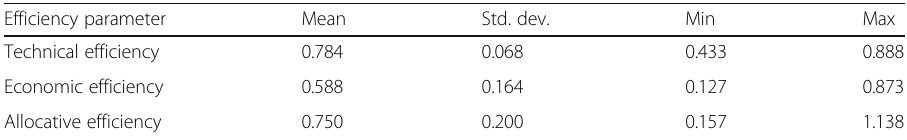
Table 4 Mean efficiencies of rice production in Northern Uganda Efficiency parameter Mean Std.